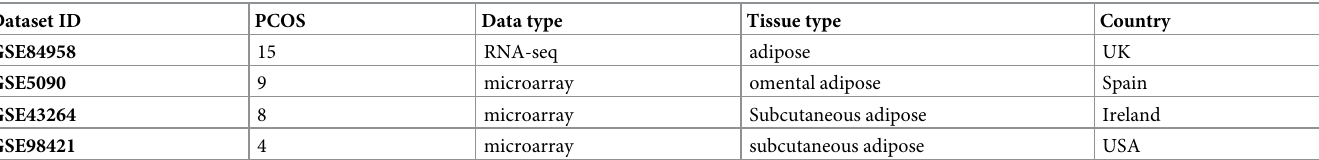
Table 1. Gene expression data from Gene Expression Omnibus (GEO)